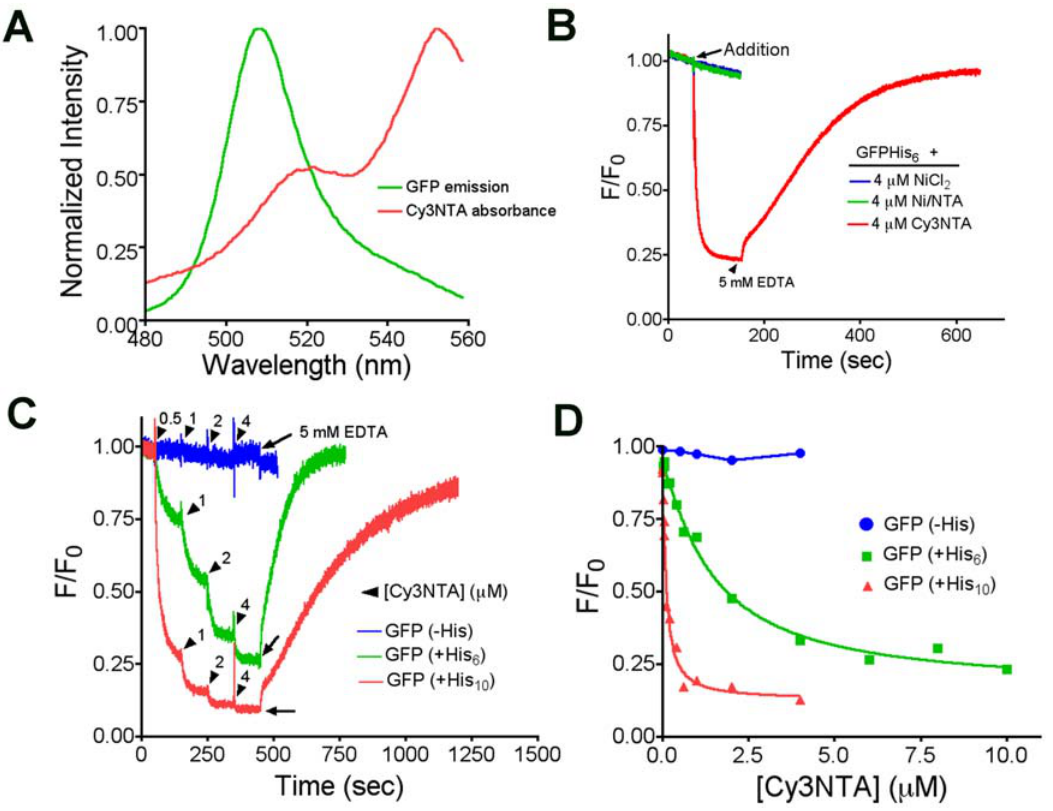
Figure 2. Cy3NTA quenches fluorescence of a His-tagged GFP. (A) Normalized GFP emission (green, l Ex =476 nm) and Cy3NTA absorbance (red) spectra. (B) Time-based measurements of GFPHis 6 fluorescence normalized to initial intensity (F 0 ). Arrow indicates point of addition of either 4 m M NiCl 2 (blue trace), Ni/NTA (green) or Cy3NTA (red). Arrowhead indicates addition of 5 mM EDTA. (C) Time-based fluorescence measurements of GFP either lacking (-His; blue trace) or containing an N-terminal His tag with either 6 (green) or 10 (red) residues. Arrowheads indicate additions of Cy3NTA at the ( m M) concentrations indicated. Arrow indicates addition of 5 mM EDTA. (D) Detailed fluorescence quenching curves for Cy3NTA binding to each of the 3 GFP constructs. Values are averages of GFP fluorescence after addition of Cy3NTA. Quenching data for His-tagged GFP constructs were fit as described in Methods.